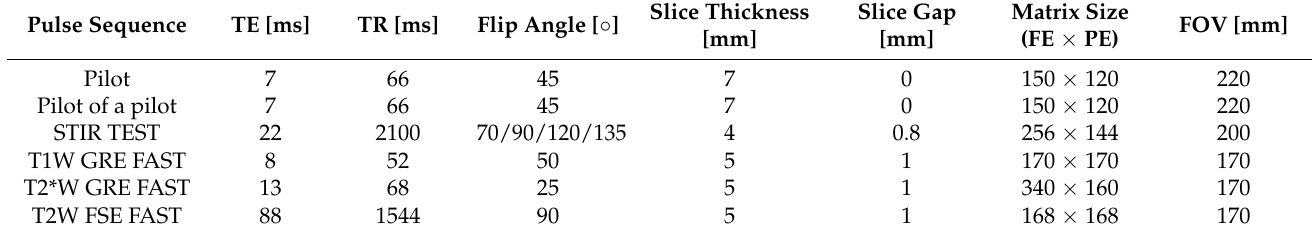
Table 1. Pulse sequence parameters used in the low-field (0.27 T) magnet to image the proximal metacarpal region of 12 endurance horses. The same parameters were used for sagittal, transverse, and